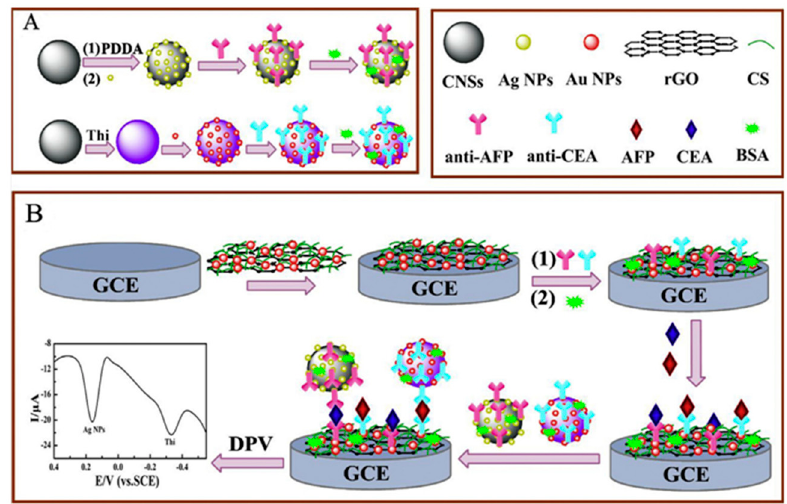
Figure 10. Multiplexed electrochemical immunosensors for detection of CEA and AFP using CNSs coated with AgNPs or AuNPs and THI for immobilization of secondary antibodies. Preparation of immunoprobes ( A ). Immunosensor fabrication procedure and recorded voltammetric signals ( B ). Reprinted from [49] with permission.